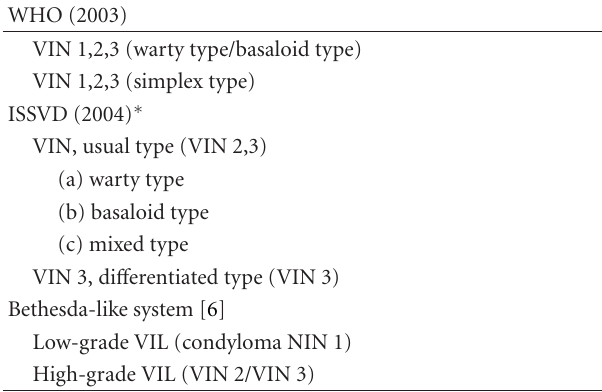
Table 2: Classifications of vulvar intraepithelial neoplasia. (WHO, ISSVD, and Bethesda-like classifications are